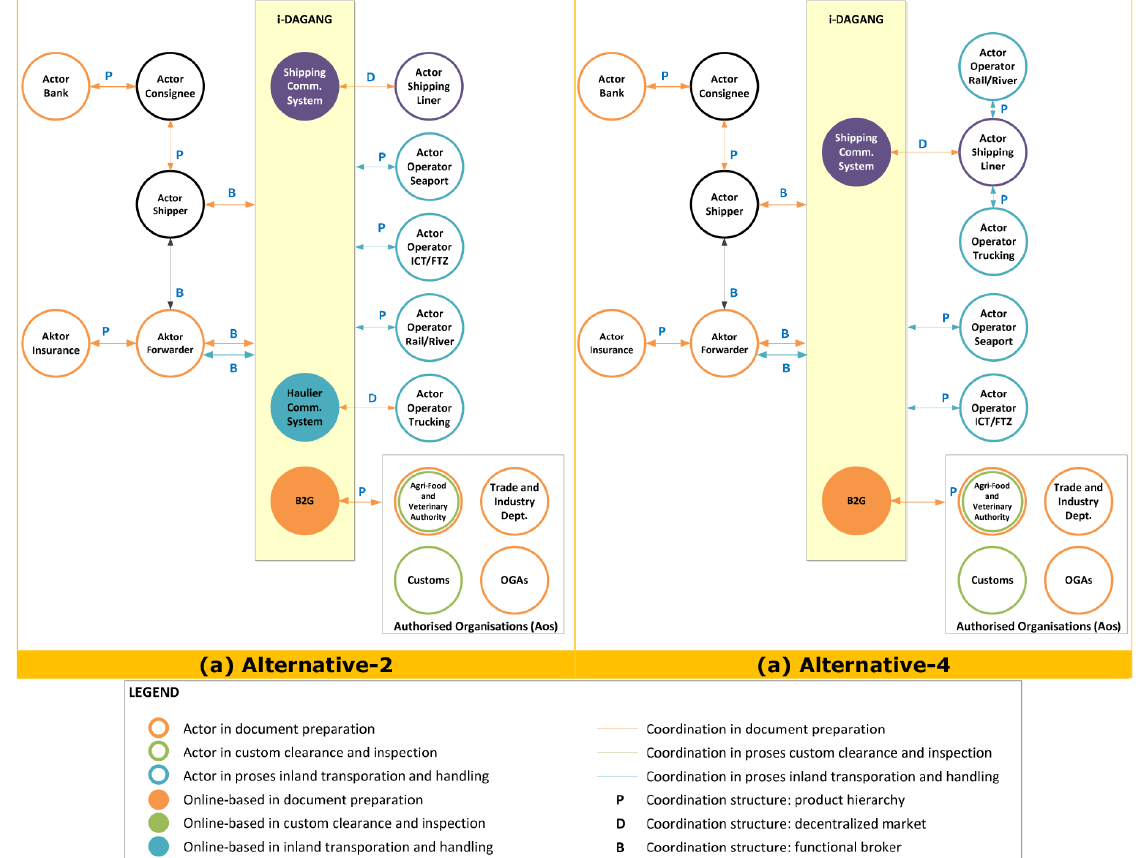
Figure 5. IOS Architecture of Best Alternative